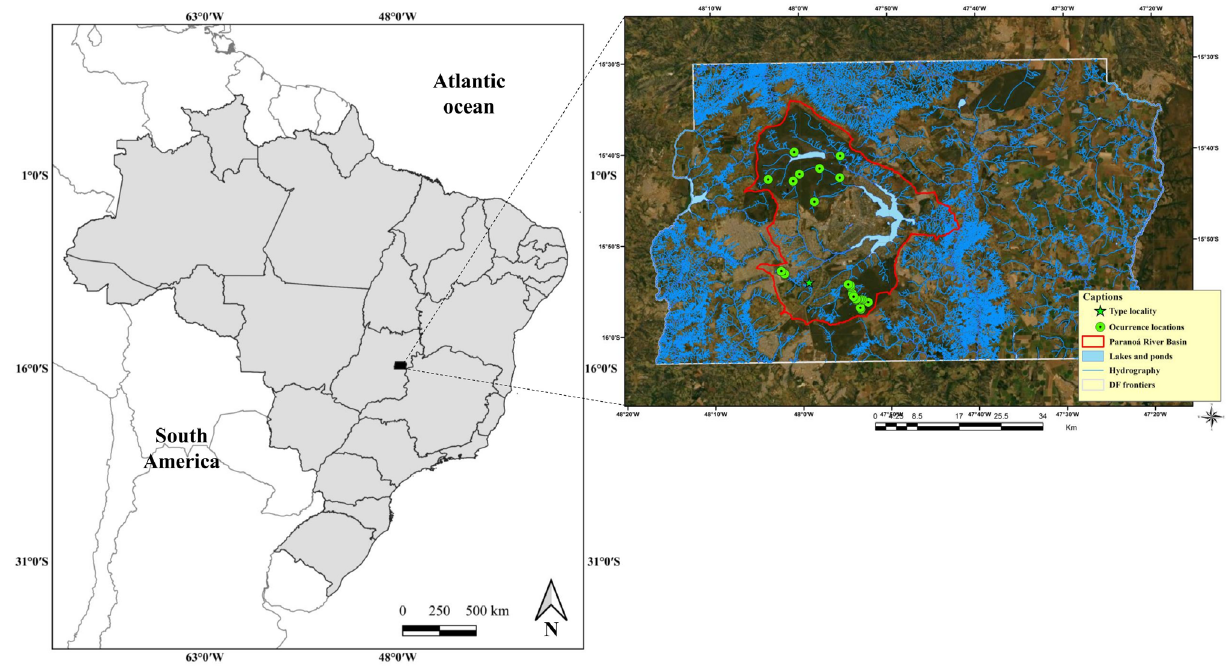
Figure 1. Brazilian territory and location of the study area in black, amplification of the study area showing streams from the Paranoá Lake basin in Brasília, Federal District, Brazil.